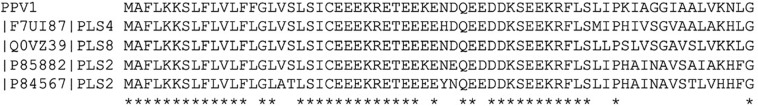
The alignment of translated open-reading frame amino acid sequences of the phylloseptin-PV1 precursor and the top four similar hits from the Uniprot database. The identical amino acids are indicated by asterisks.